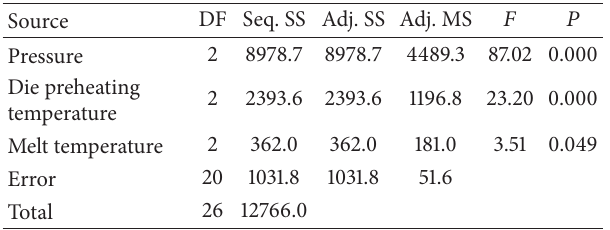
Table 8: Analysis of variance for UTS using adjusted SS for tests.